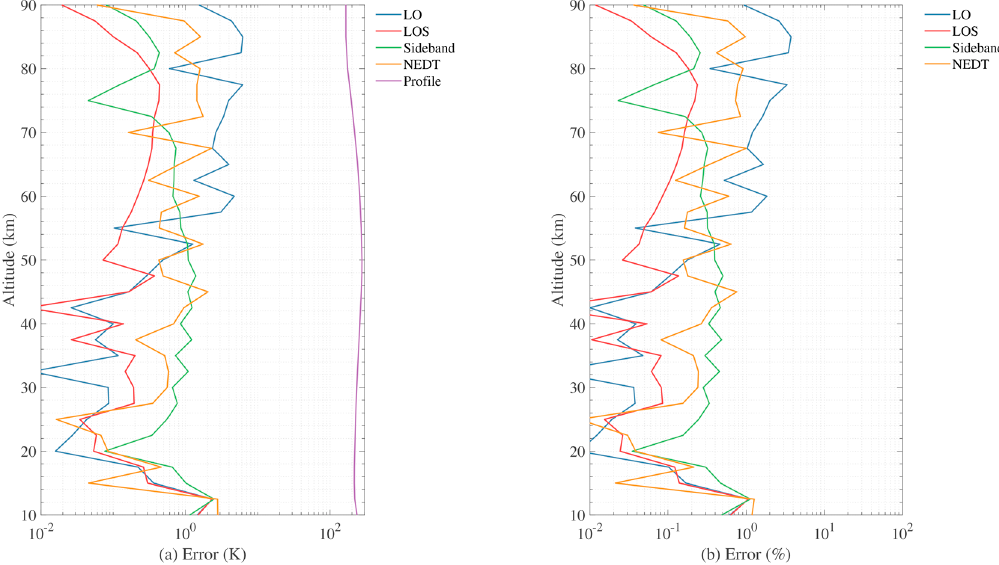
Figure 5. The temperature retrieval errors induced by different instrument uncertainty sources: ( a ) absolute and ( b ) relative retrieval errors. The uncertainties assumed are summarized in Table 3.